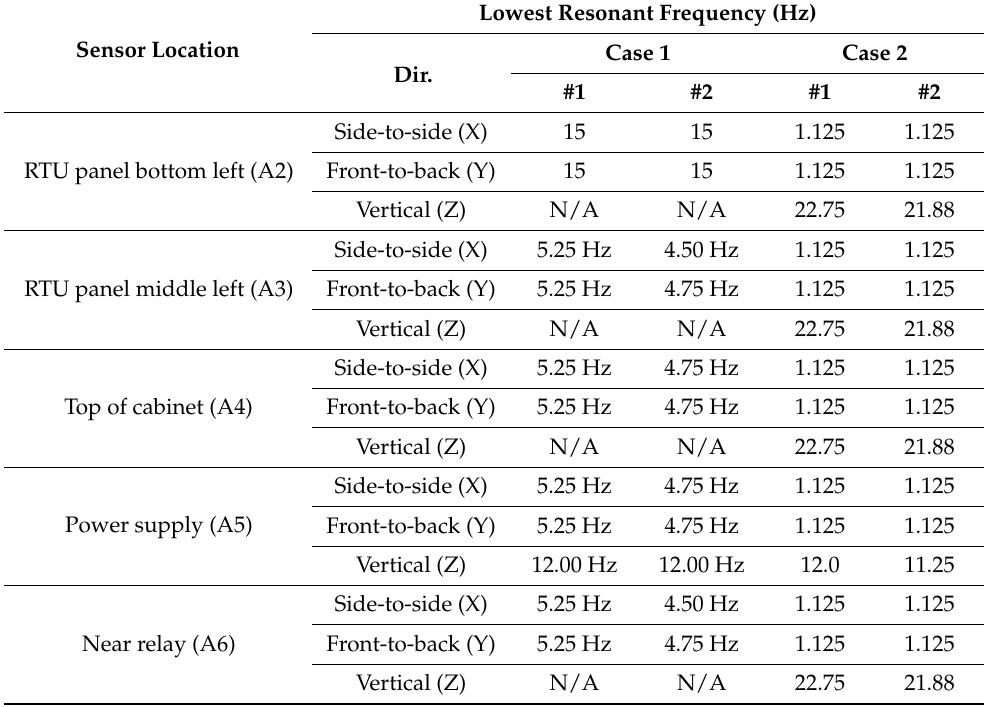
Table 7. Estimated resonant frequencies from the experimental tests.